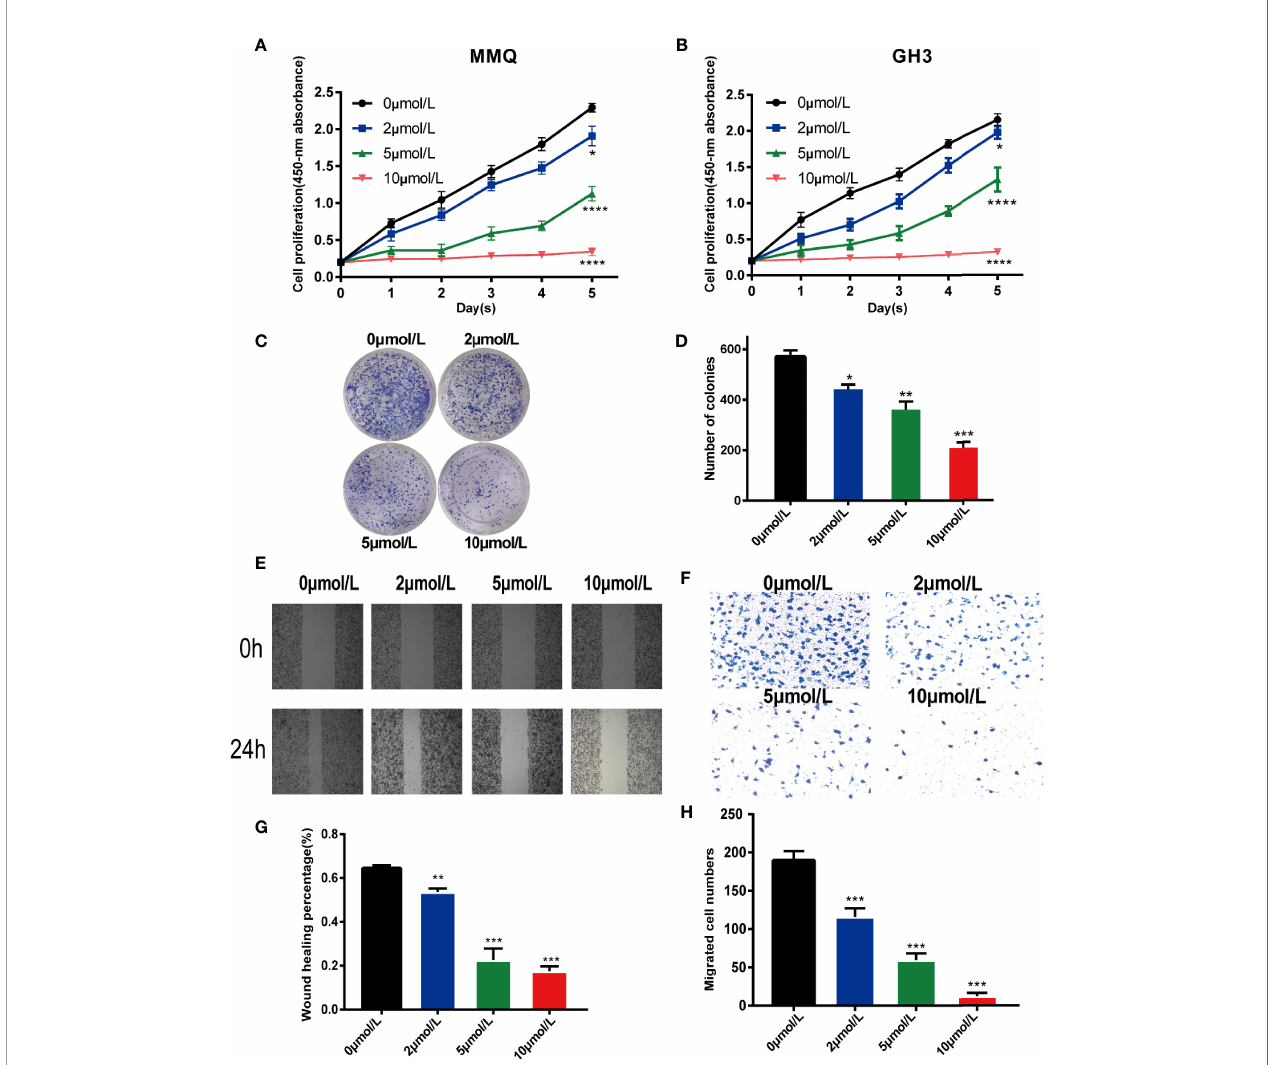
FIGURE 3 | HI-TOPK-032 inhibited the proliferation and migration of pituitary tumor cells. (A) The proliferation capability of MMQ cells detected by CCK-8 assay. (B) The proliferation capability of GH3 cells detected by CCK-8 assay. (C) Cell cloning formation ability measured by plate-based Colony formation assay. (D) The number of cell clones was statistically analyzed and histogram was drawn. (E) Wound healing assay was used to detect the migration ability of GH3 cells. (F) Transwell assay detected the migration ability of GH3 cells. (G) Statistical analysis results of Wound healing assay. (H) Statistical analysis results of Transwell assay. * P < 0.05; ** P < 0.01; *** P < 0.001; **** P <